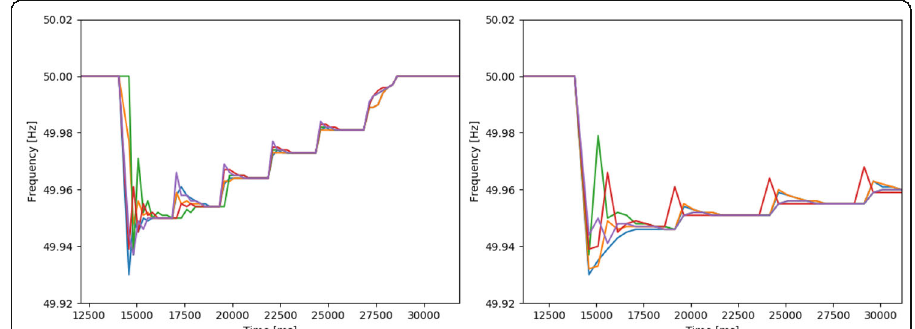
Fig. 5 Distributed consensus negotiation for frequency stabilization after a disturbance. Each color represents the proposed value of a single node. After each consensus iteration, that consensus value is used by each node to control the corresponding energy resource of the simulated micro grid. The left graph shows normal operation, whereas the right one shows the system during a DoS